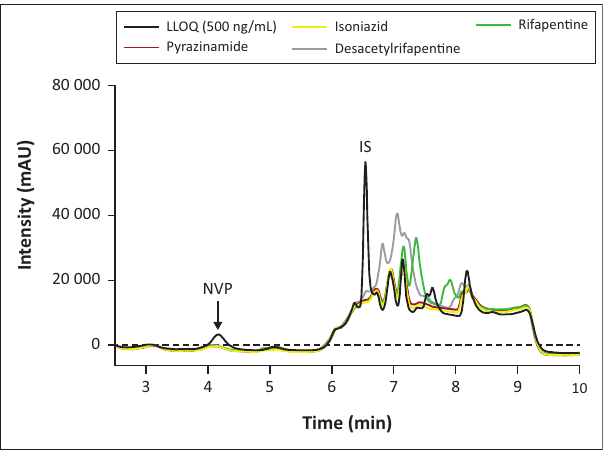
FIGURE 4: Chromatogram overlay of LLOQ with anti-tuberculosis drugs; no interference was observed at nevirapine and internal standard retention times.